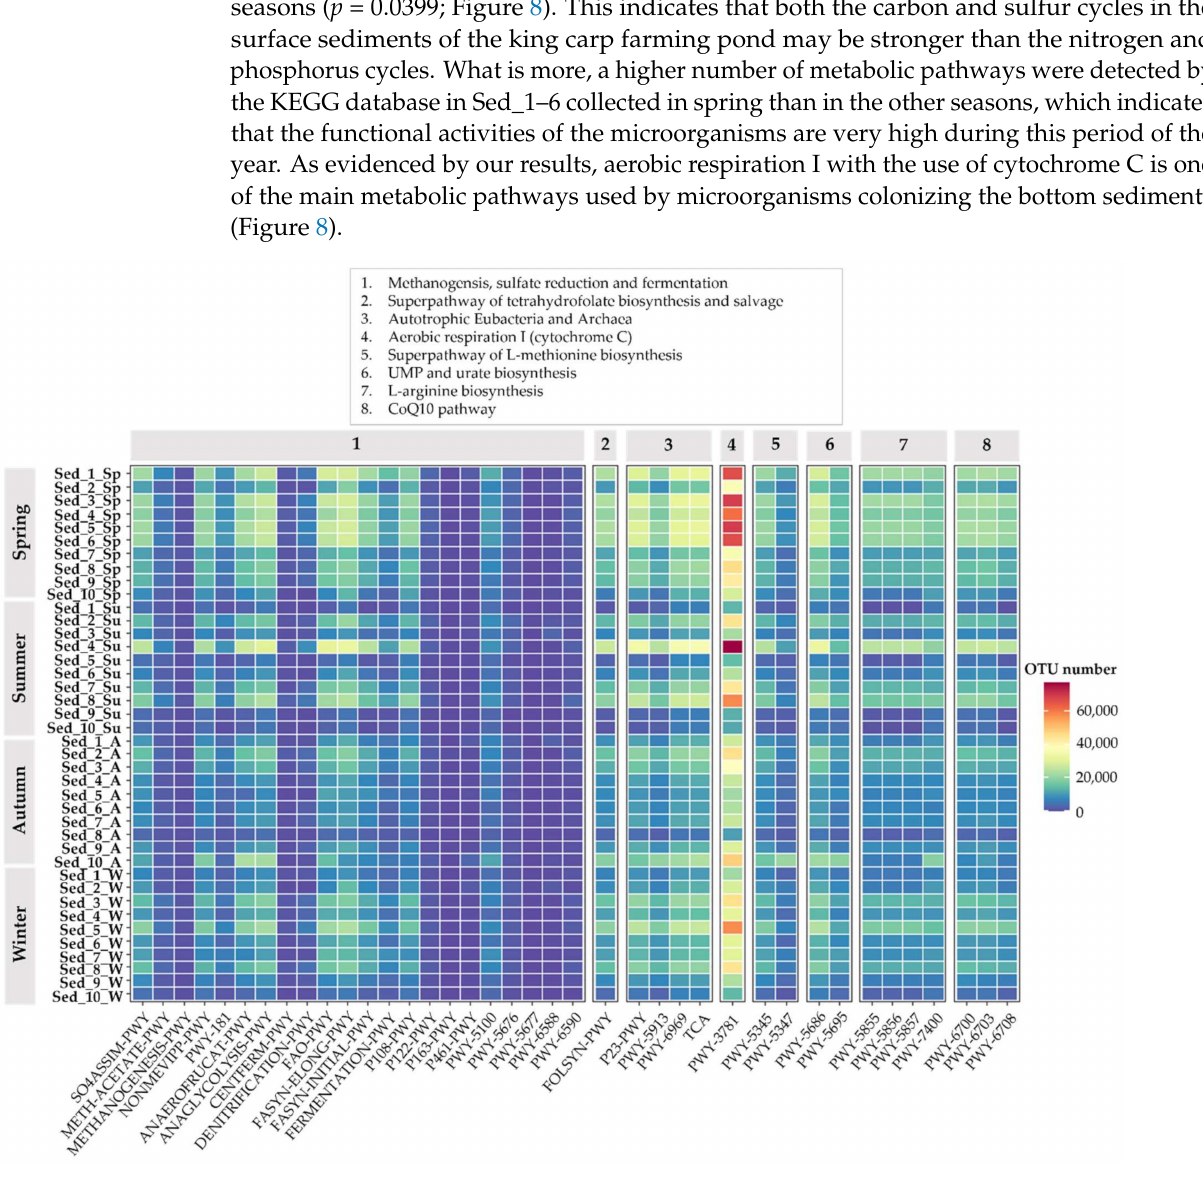
Figure 8. Heat map of the pathways annotated by eight pathway clusters